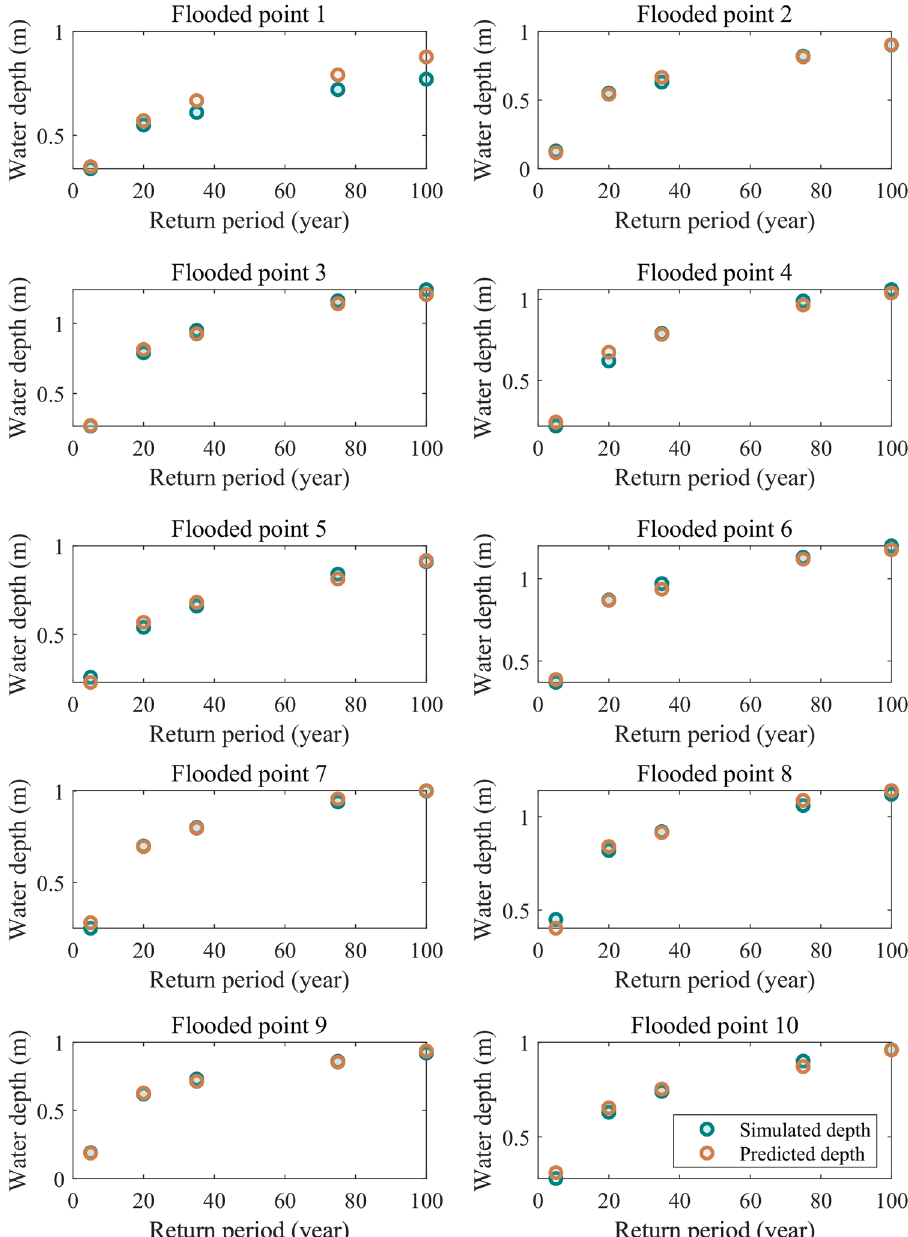
Fig. 9 The light gradient boost- ing machine (LightGBM) model prediction results for 10 flood- prone points under different return